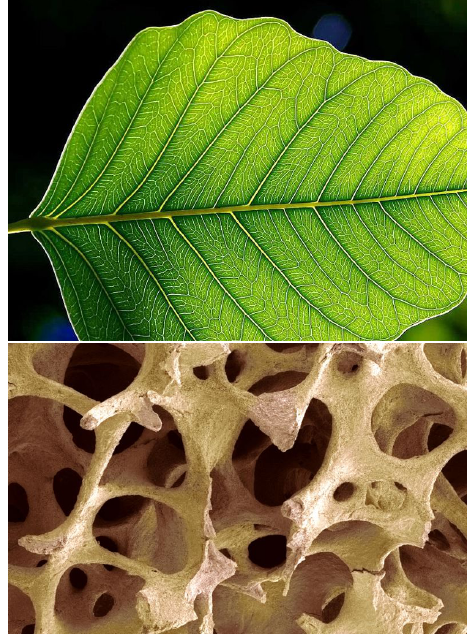
Figure 1. Various application of trabecular structures in nature [1]. In the top we can see the structure of leaf. In the bottom, we can see trabecular bone morphology